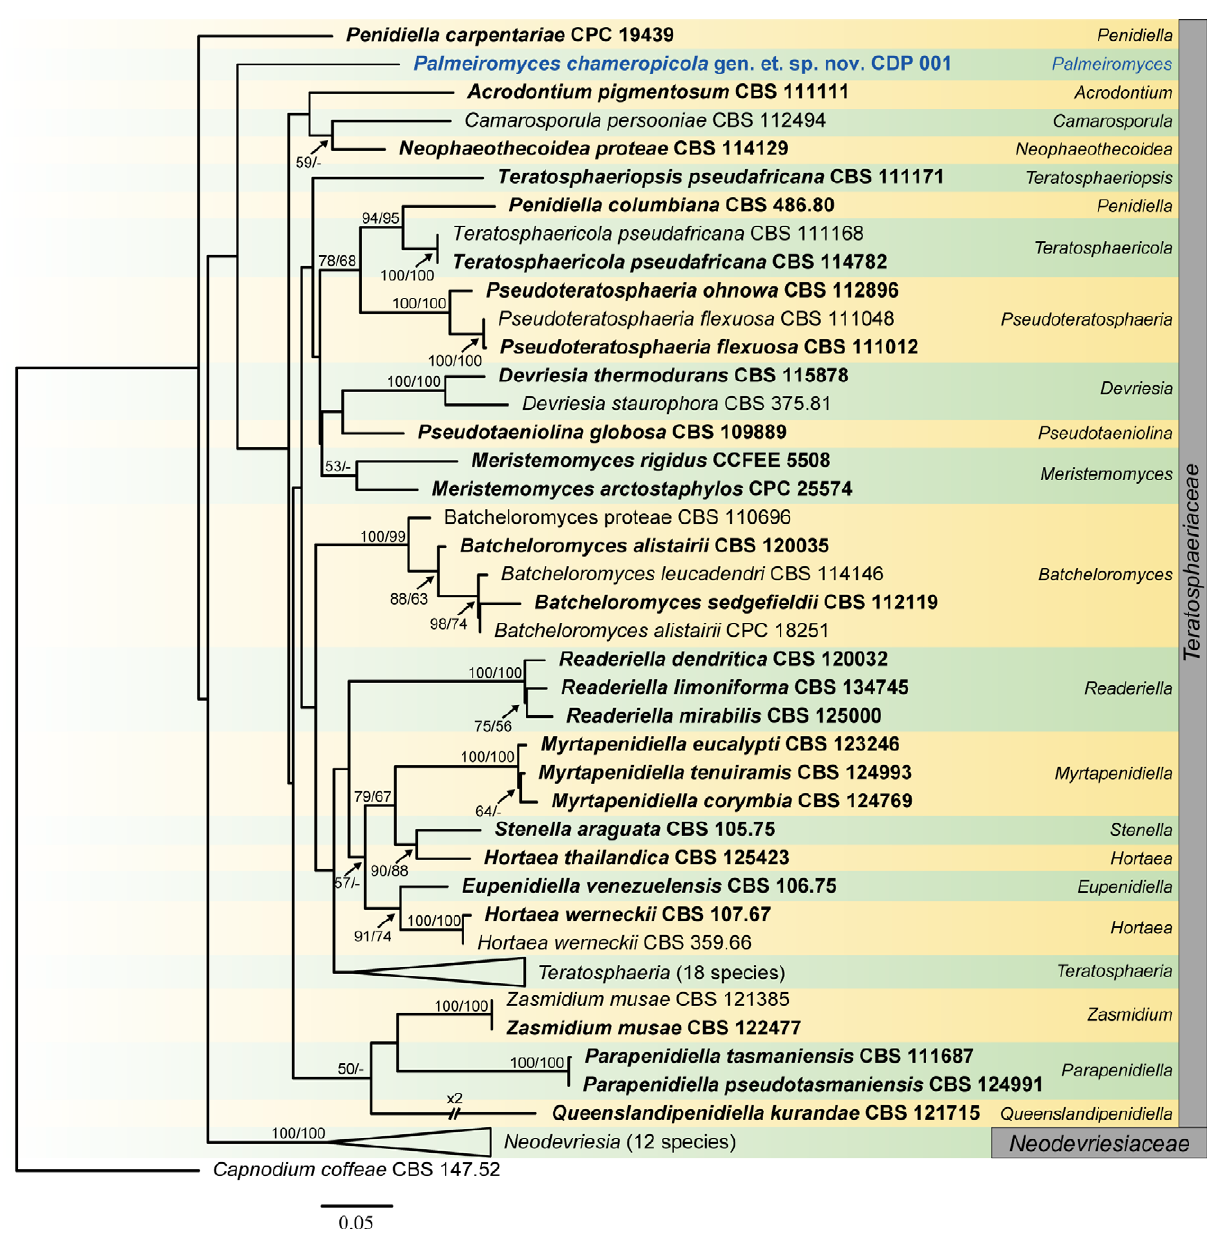
Figure 2. Maximum likelihood tree of Teratosphaeriaceae and Neodevriesiaceae based on combined ITS and LSU sequences. ML/MP boot- strap support values (> 50%) are shown above the branches. The isolate from Chamaerops humilis is indicated in blue font. The scale bar represents the expected number of nucleotide changes per site. Ex-type/ex-epitype isolates are in bold